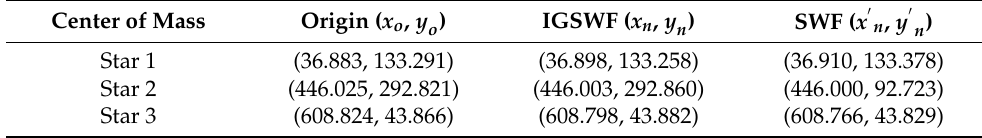
Table 1. The center of mass.